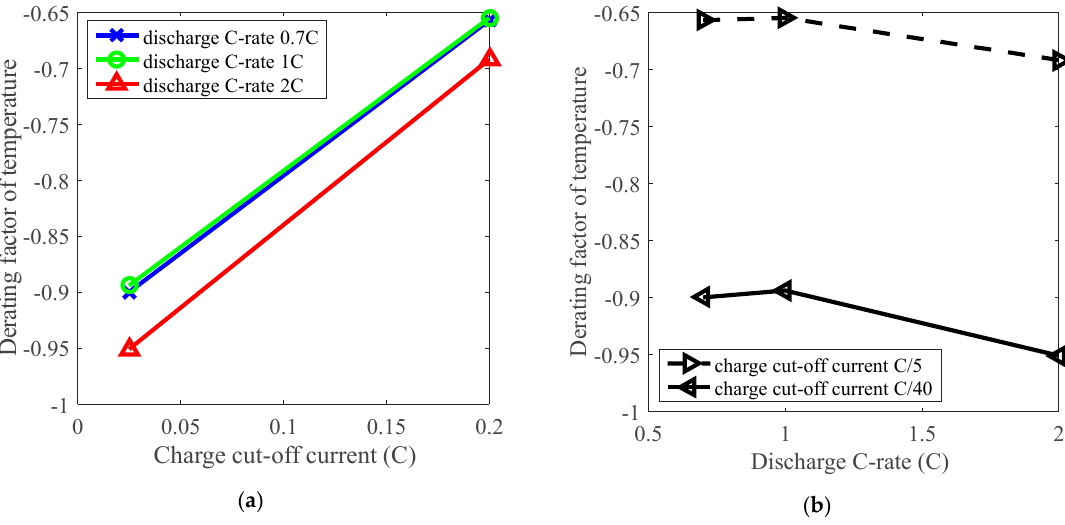
Figure 6. The effects of charge cut-off current and discharge C-rate on derating of temperature. (a) Derating factor of temperature vs. charge cut-off current; (b) Derating factor of temperature vs. discharge C-rate.